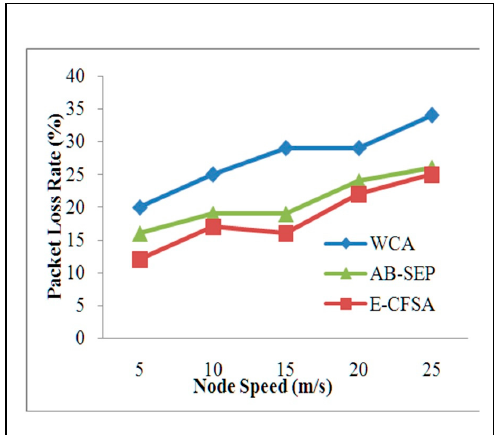
Figure 15. Graph Packet loss ratio Vs. Node speed.